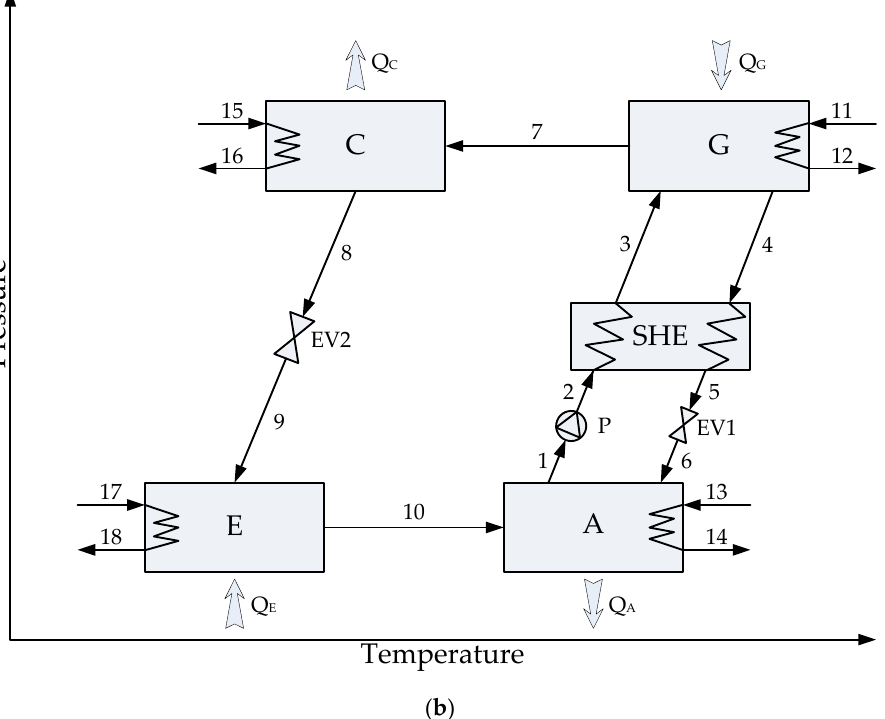
Figure 1. ( a ) Schematic representation of the single e ff ect absorption refrigeration system, and ( b ) the pressure–temperature (P–T) diagram of the